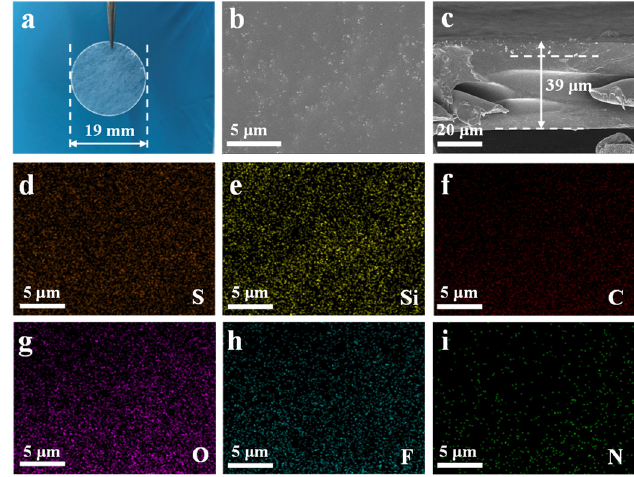
Figure 2. Physical characterization of RTS-5% SiO 2 QPE. ( a ) Digital photograph of the QPE. ( b ) SEM image of the QPE surface. ( c ) Cross-section SEM image of the QPE. ( d – i ) EDS mapping images of S, Si, C, O, F, and N elements in the QPE.